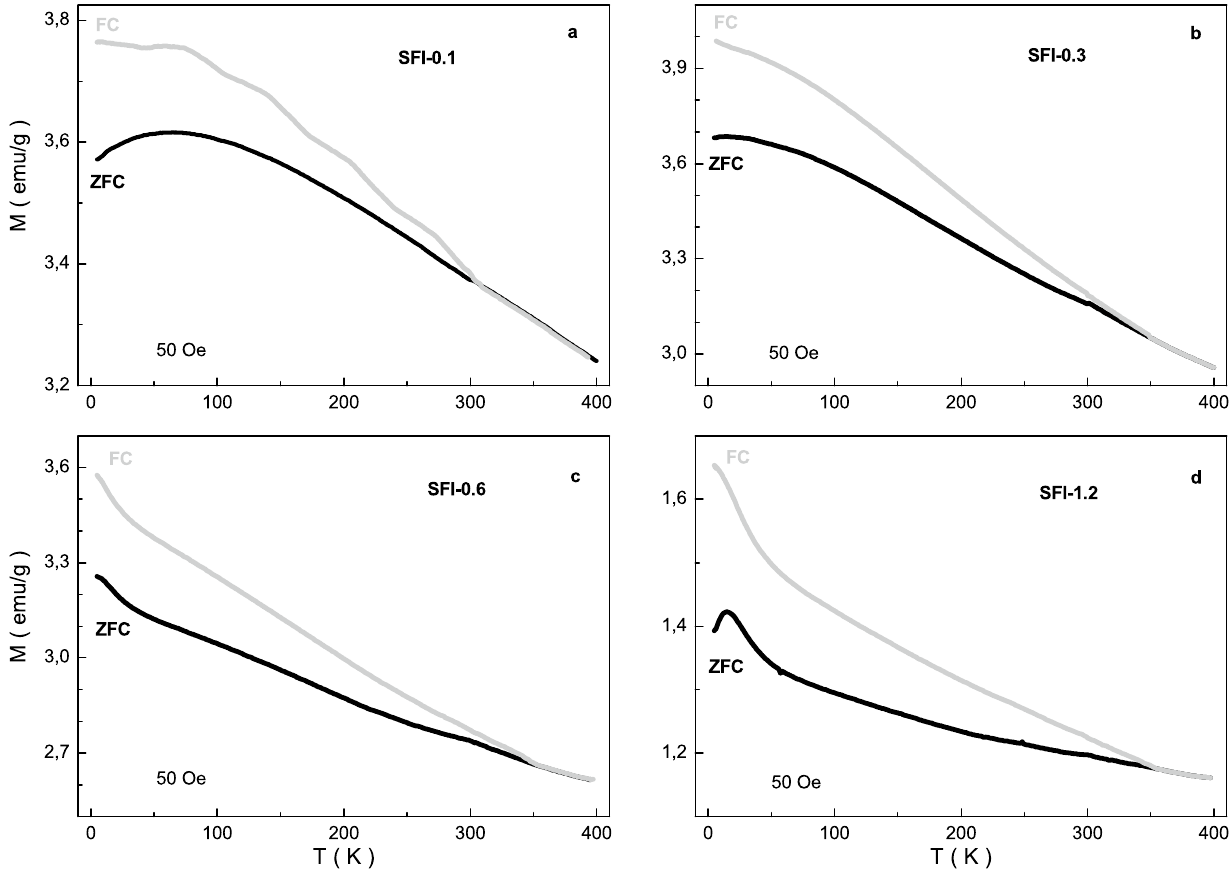
Figure 4. Graph of ZFC (black line) and FC (grey line) magnetization vs. temperature in a field of 50 Oe for the samples SFI-0.1 ( a ), SFI-0.3 ( b ), SFI-0.6 ( c ) and SFI-1.2 ( d